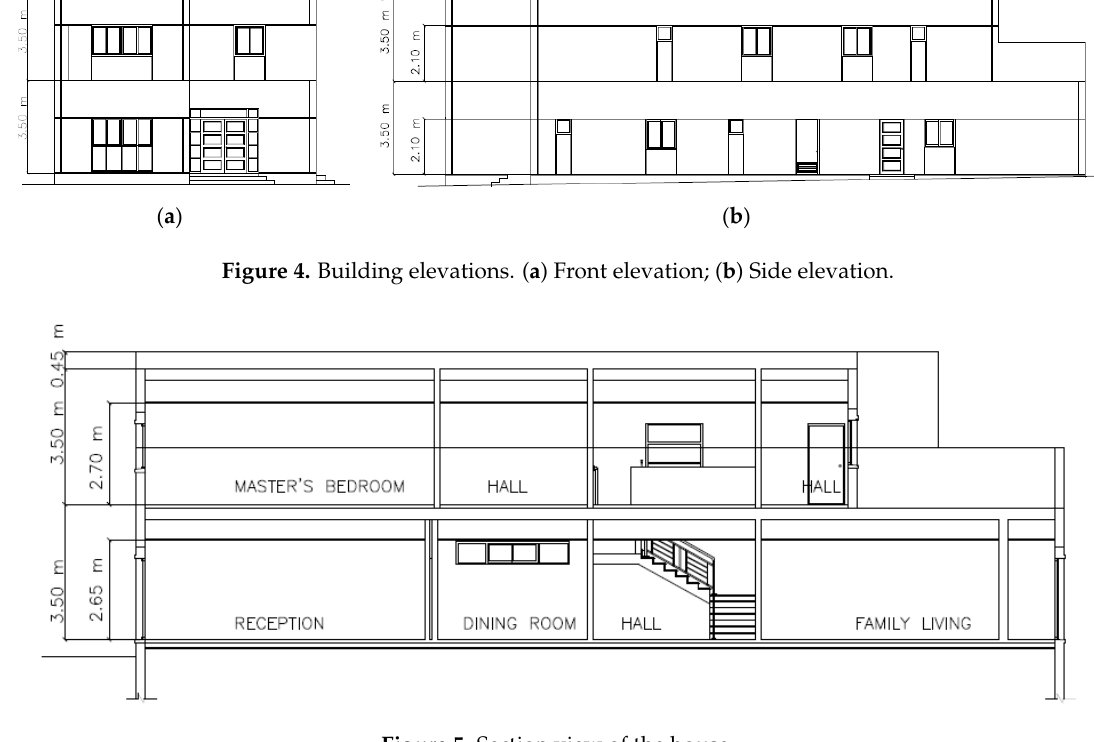
Figure 5. Section view of the house. Table 1. Main structural details of the house.